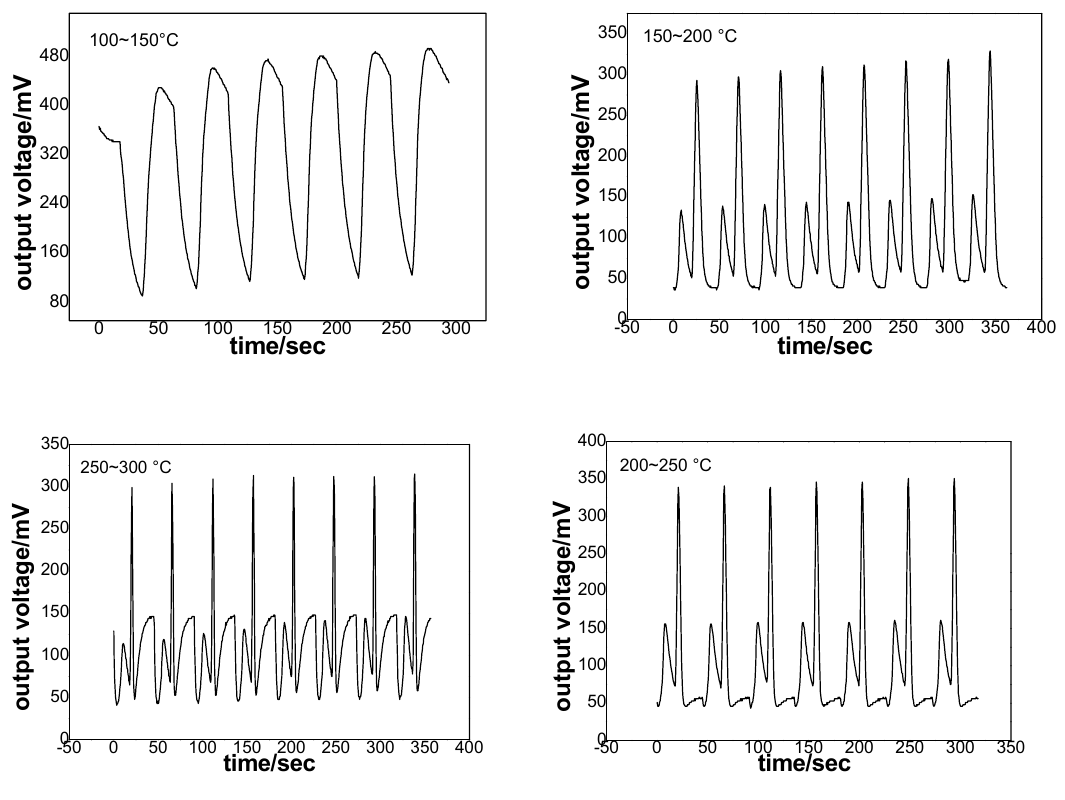
Figure 4. Effect of temperature on the responses of 0.5 ppm acetone at a frequency of 20 mHz in a rectangular